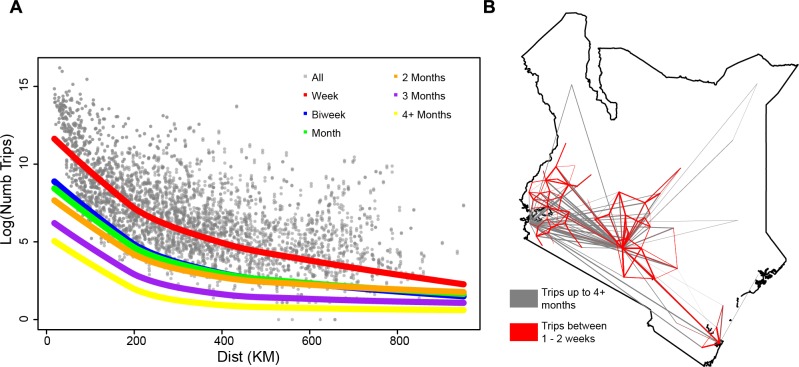
The impact of the duration of journeys on travel between districts.A) For travel between pairs of locations, we compared the number of trips (log) versus the distance (km) for all journeys (grey) and the best fit lines for trips lasting up to between one and two weeks (red), between two weeks and one month (blue), between one and two months (green), between two and three months (orange), between three and four months (purple), and trips lasting four months or more (yellow). As the duration of journeys increased, the amount of travel between districts decreased. B) For all trips including any trip duration (red) and those lasting 4+ months (grey), the top 5% of of routes are shown based on the total amount of travel. For trips lasting short durations, there is a large amount of travel between nearby districts. For trips lasting long durations, the majority of these top routes are to/from major cities including Nairobi and Mombasa.